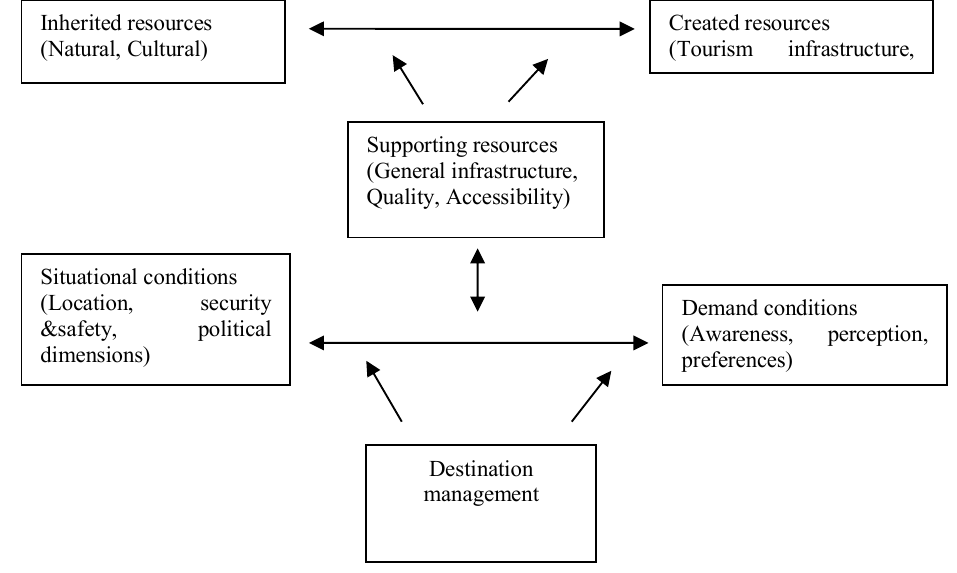
Figure 1: Integrated model of destination competitiveness Source: (Goeldner, Ritchie & Mcintosh,